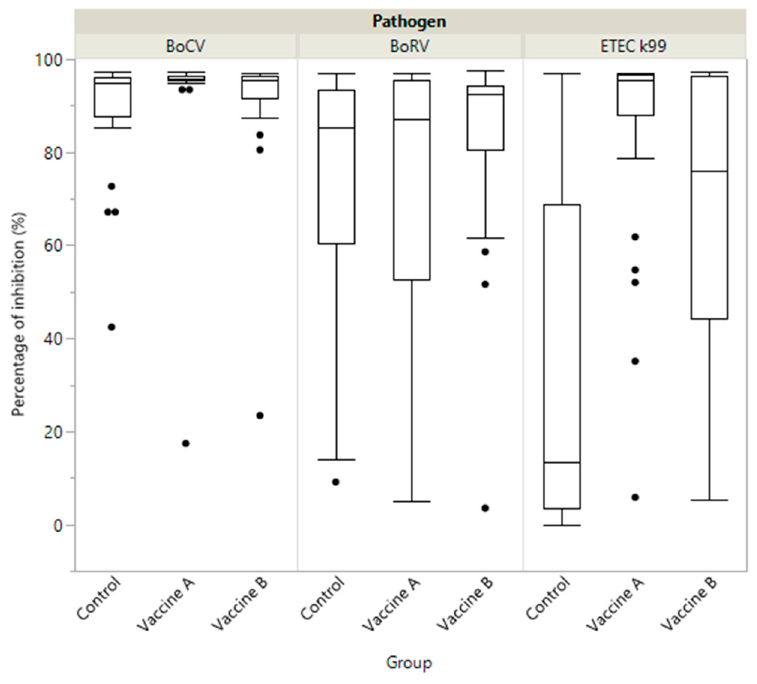
Figure 3. Boxplot showing specific immunity represented as percentage of inhibition (PI) of antibody in calves by study group (Vaccine A, Vaccine B and Control) against coronavirus (BoCV), enterotoxigenic E. coli (ETEC K99) and Rotavirus (BoRV).